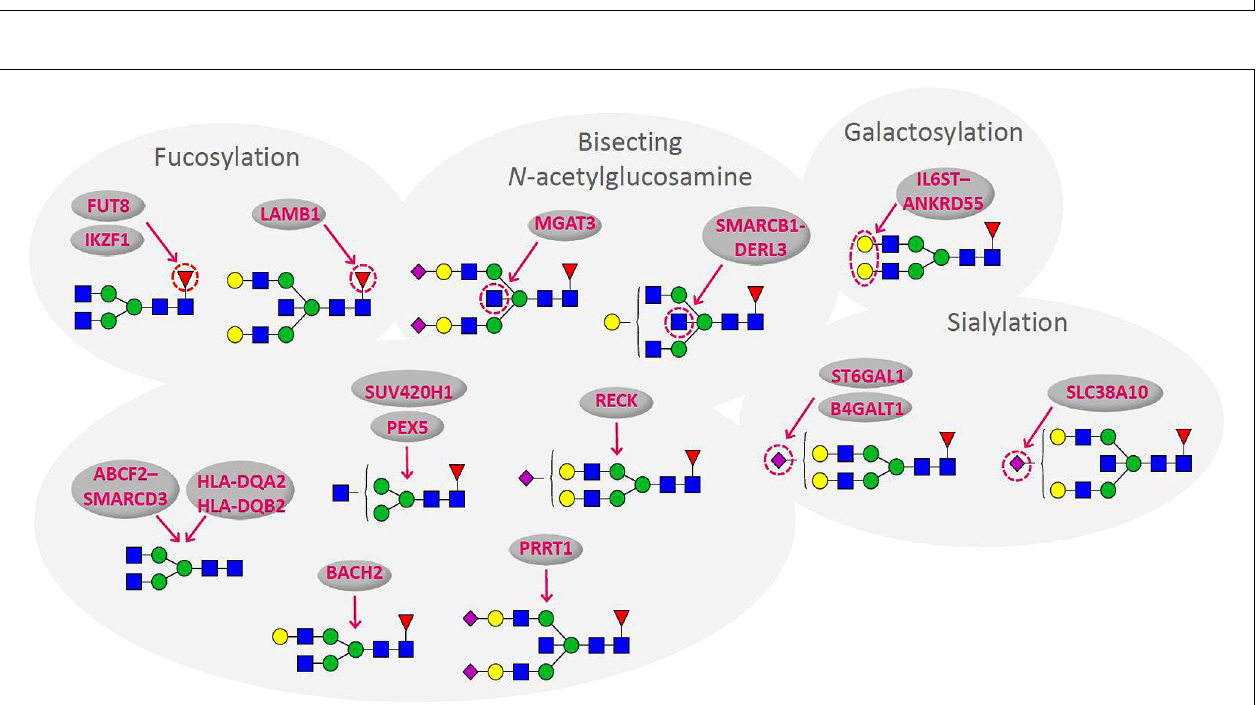
FIGURE 1 | Inter-individual difference in composition of the glycome attached to immunoglobulin G (IgG) between six individuals. The term glycome refers to the sum of all glycans that are attached to IgG molecules within an individual.The different (arbitrary) colors represent different N -glycan structures that can be attached to IgG molecules within an individual.